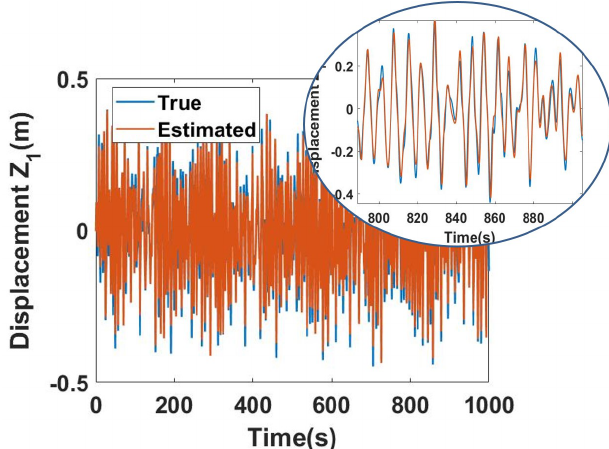
Fig. 6: The estimation of the displacement ( z 1 ) of the first